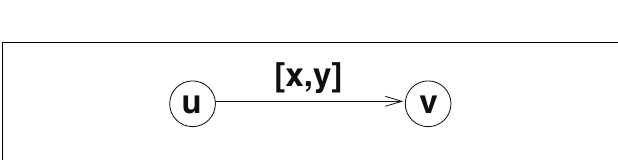
FIGURE 1 | A directed graph with vertices v ranges.